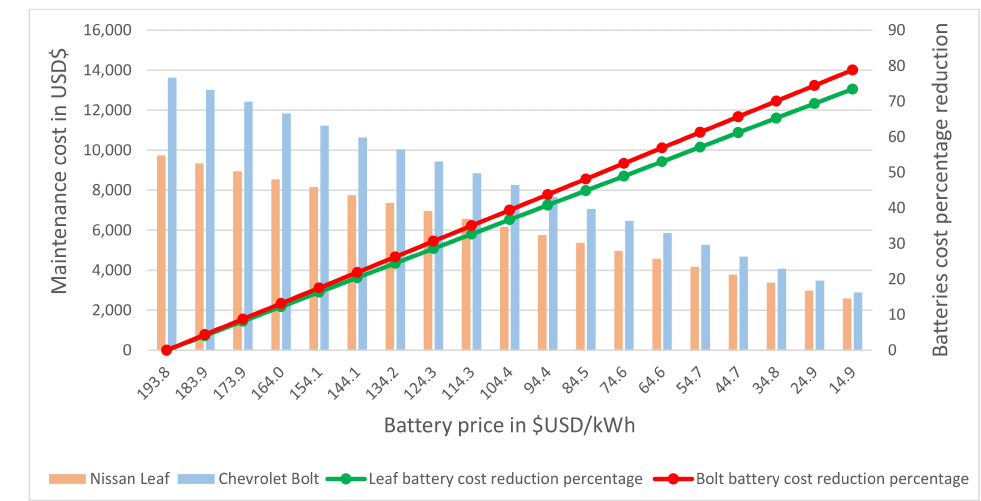
Figure 12. Decrease in the battery cost percentage given a battery price of